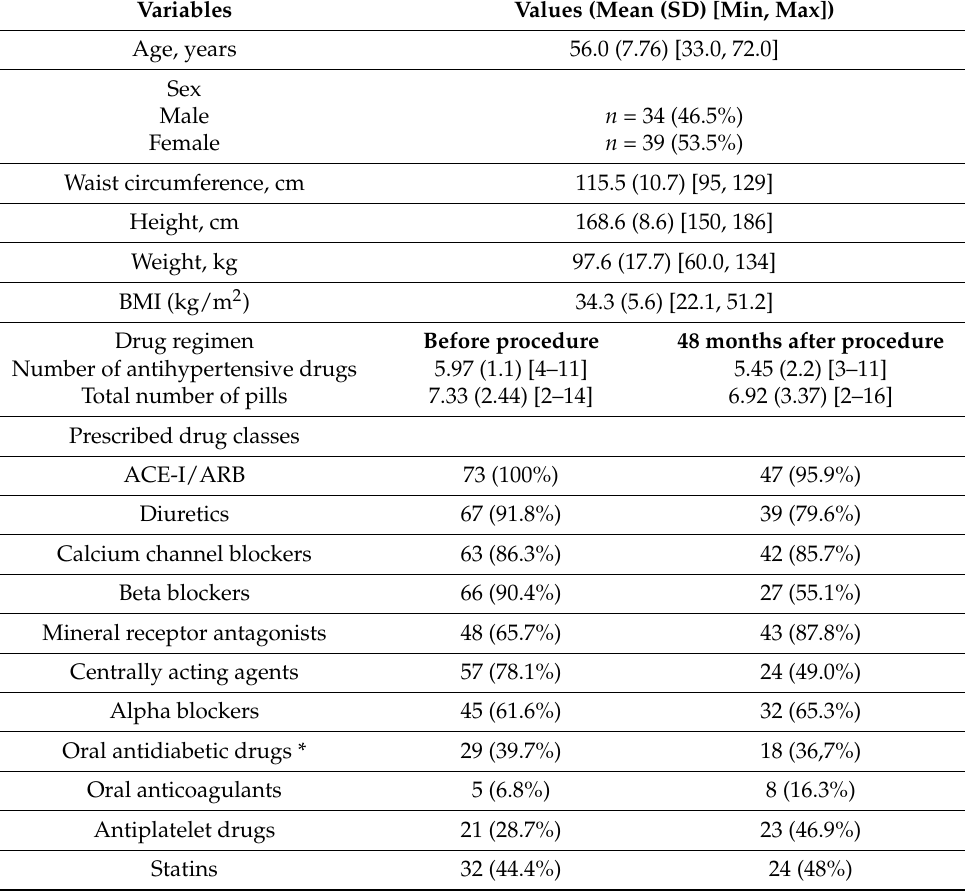
Table 1. Baseline characteristics of the study population before